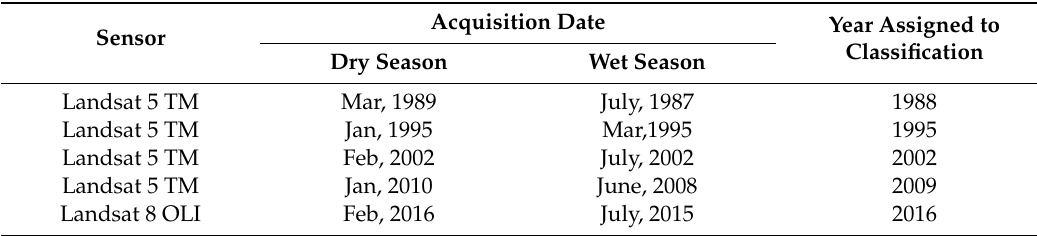
Table 2. Characteristics of satellite images used for